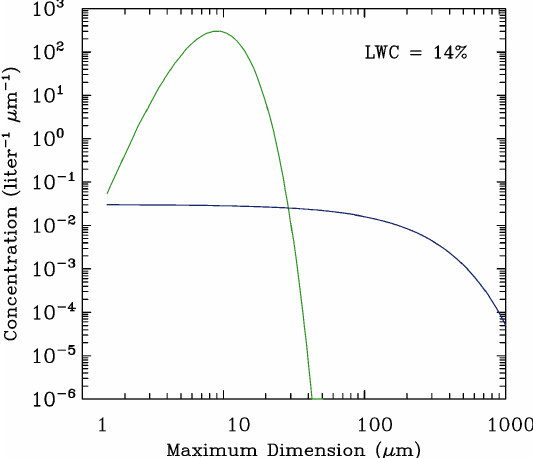
Fig. 6. Algorithm framework with a variable droplet size distri- bution in green and a temperature-dependent anvil cirrus PSD in blue. The liquid water content (LWC) of the droplet size distribu- tion shown here is 14% of the total condensate